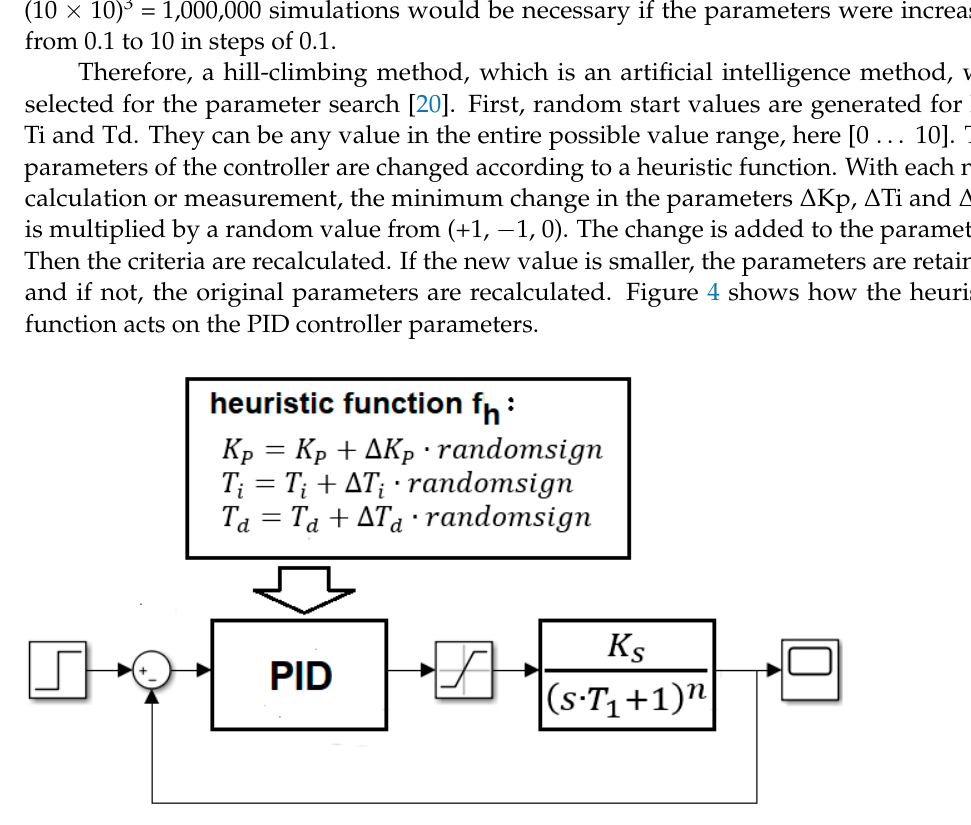
4 Figure 3. Illustration of the control error e(t) in the closed loop, as a basis for the IAE, ITAE and ISE criteria. 3. The Hill-Climbing Method for Calculating the PID Controller Parameters